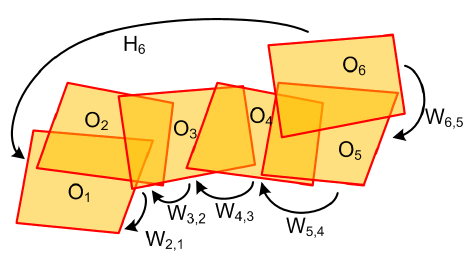
Figure 7. Computing the transformation matrix H of an orthoframe as a chain product of i the alignment matrices W between consecutive frames of the input i,i − 1